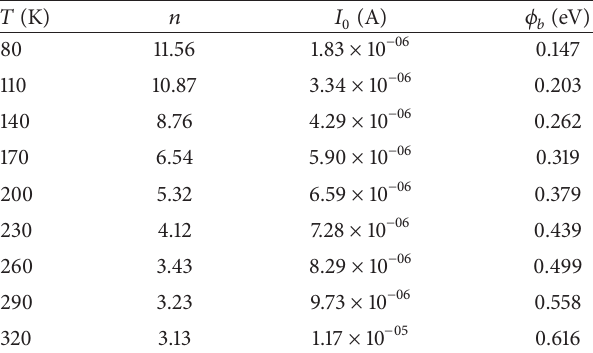
Table 1: The 𝑇 , 𝑛 , 𝐼 0 , and 𝜙 𝑏 values for the investigated device structure of Figure 1.